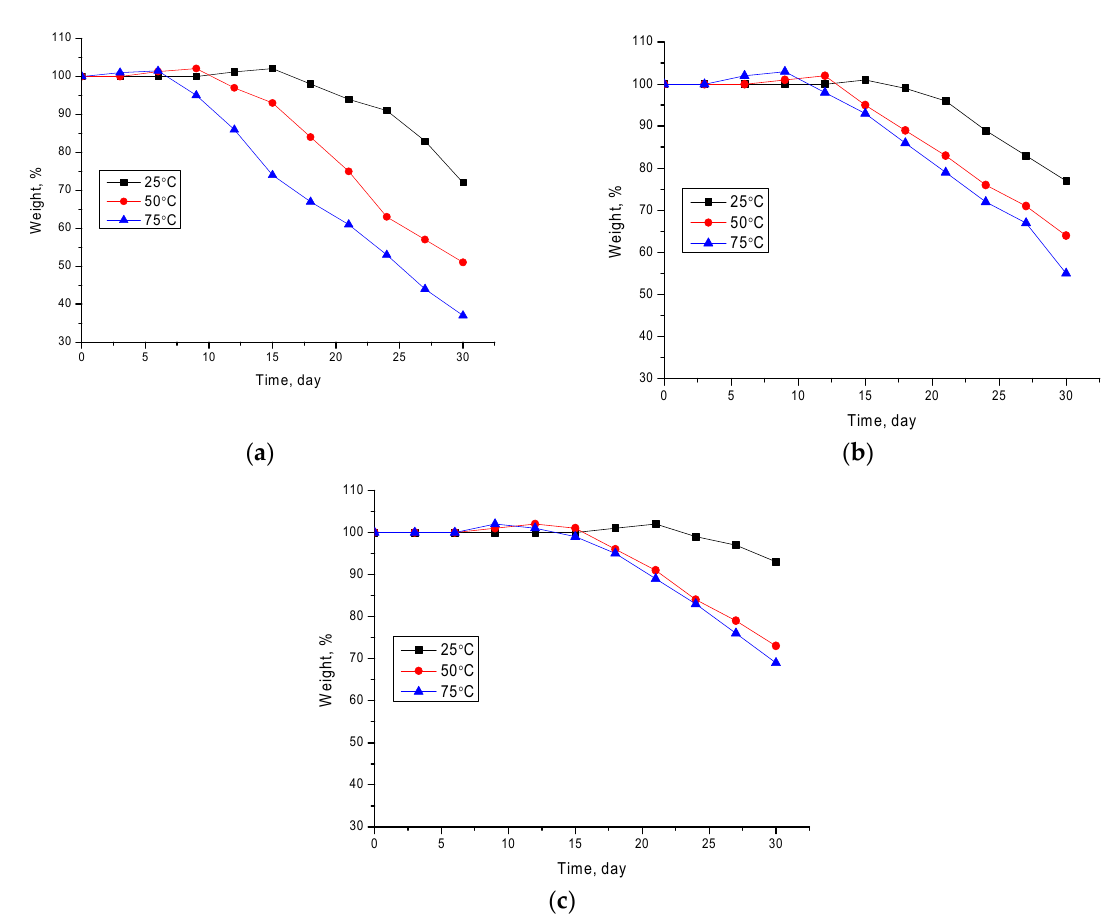
Figure 3. Graph of changes in the mass of ceramics depending on the time spent in the medium: ( a ) LTO-1; ( b ) LTO-2; ( c ) LTO-3.